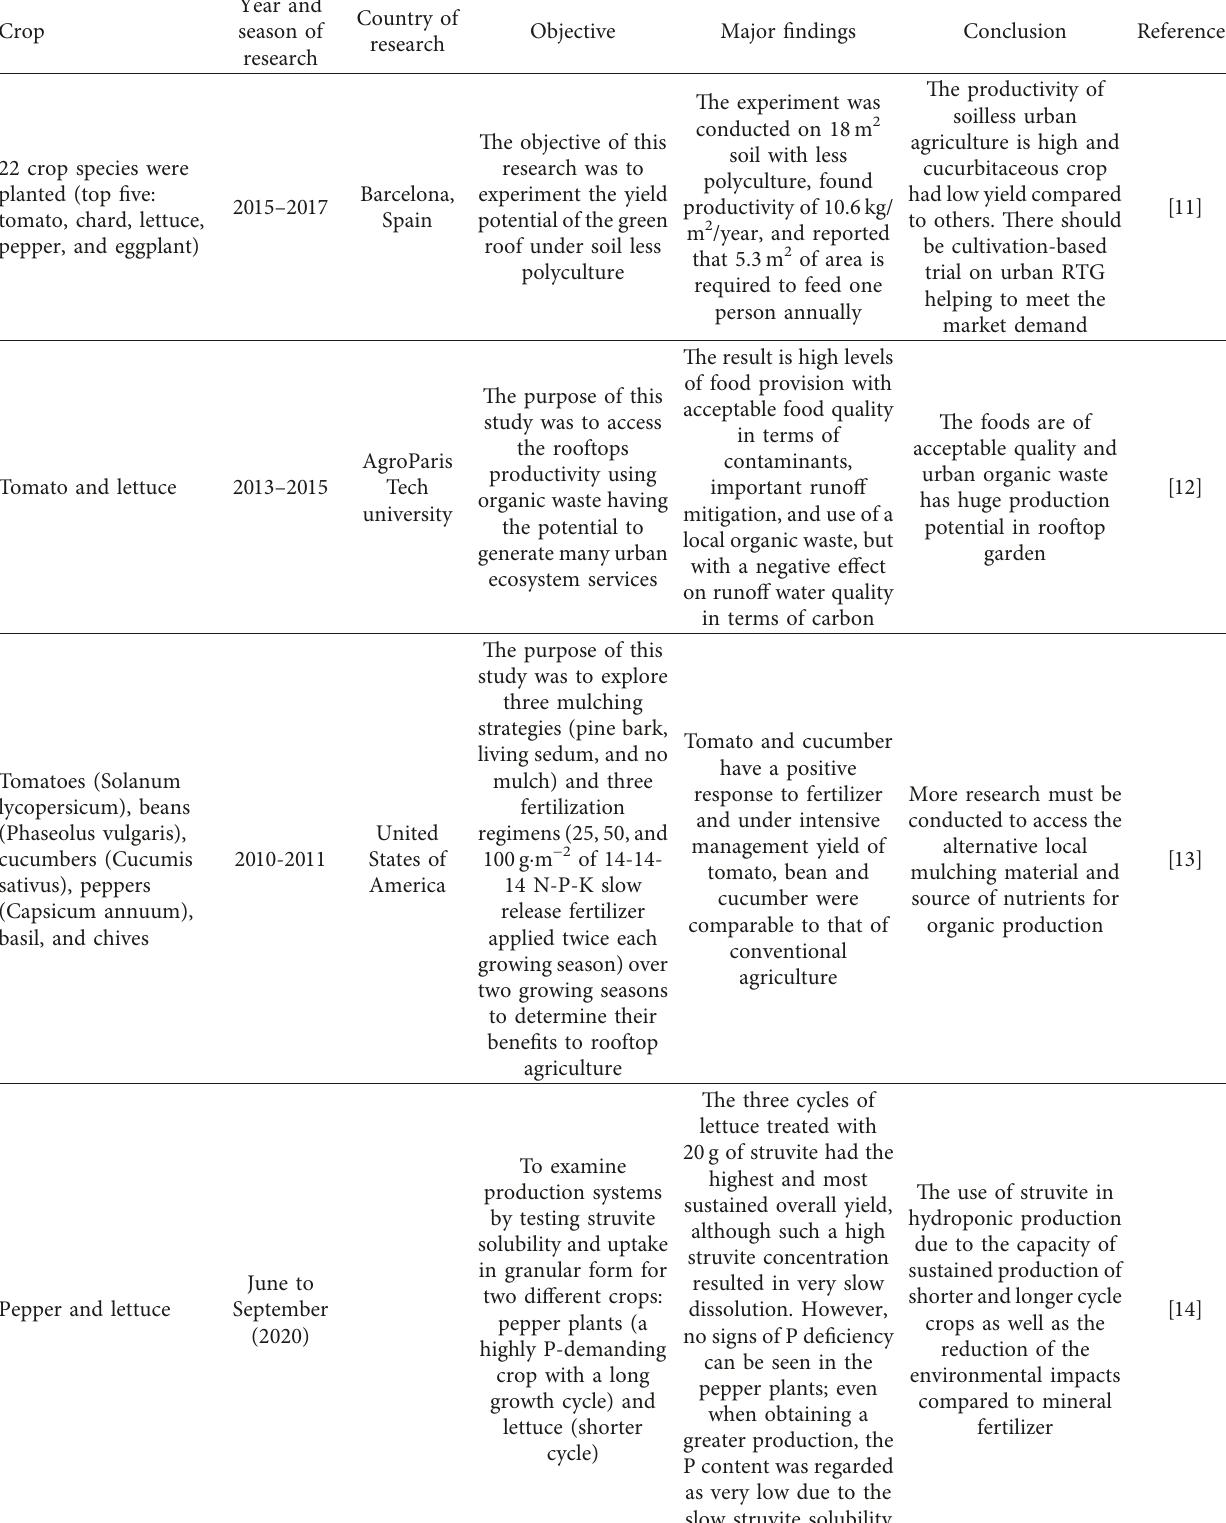
Table 1: Production status and environmental benefits acquired from urban green roofs: literature review.